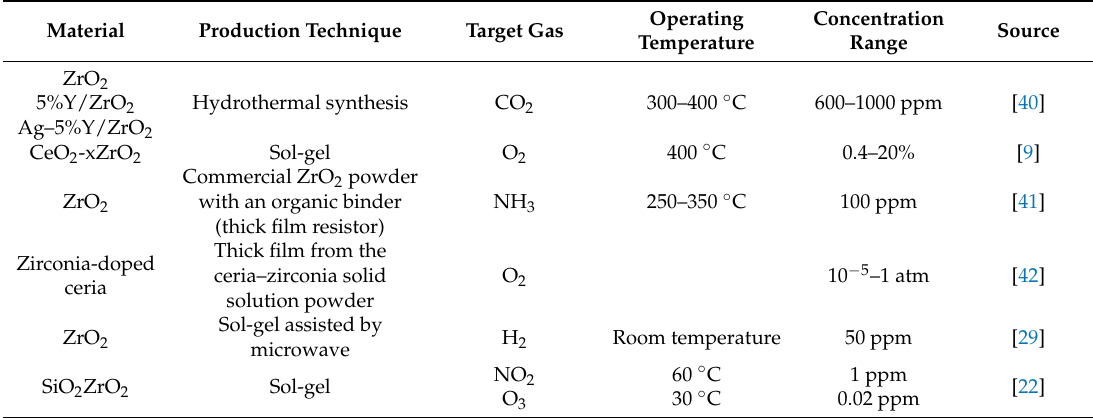
Table 2. Comparative characteristics of resistive zirconia-based gas